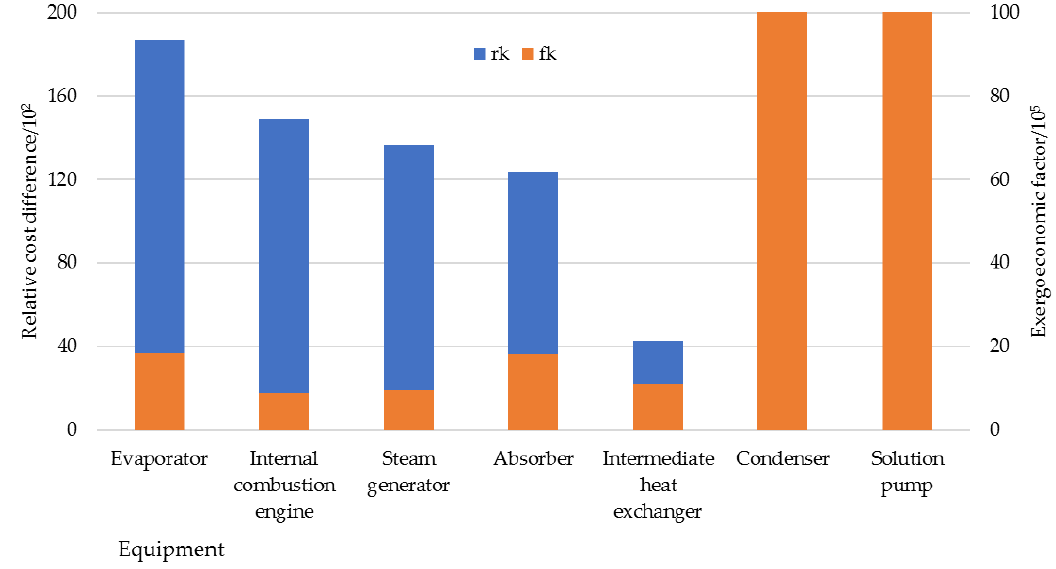
Figure 3. Relative cost di ff erence (r k / 10 2 ) and exergoeconomic factor (f k / 10 5 ) for each piece of equipment.